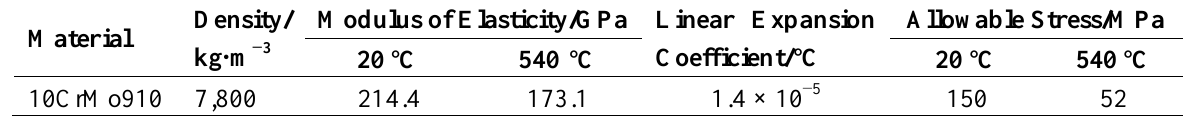
Table 1. Material properties and design parameters of the